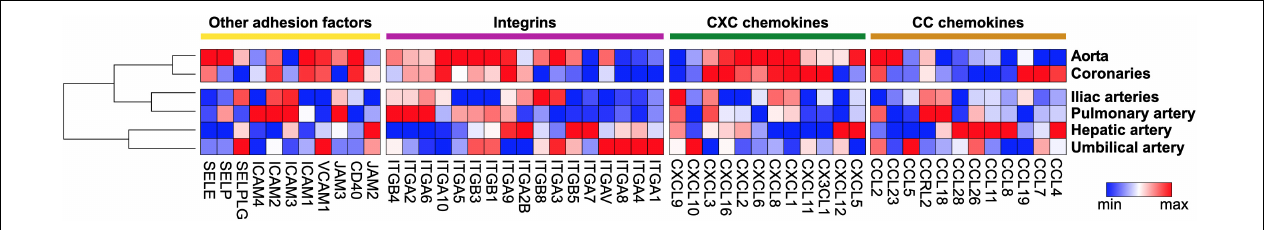
FIGURE 1 | Gene expression pattern of adhesion factors expressed in human endothelial cells. Baseline gene expression of human endothelial cells from different locations was extracted from the curated gene set collection of the EndoDB database (Khan et al., 2019). Extracted expression values were plotted as heatmap by Morpheus with column minimum and maximum normalization. Within classes of adhesion receptors, rows and columns were sorted by hierarchical clustering.